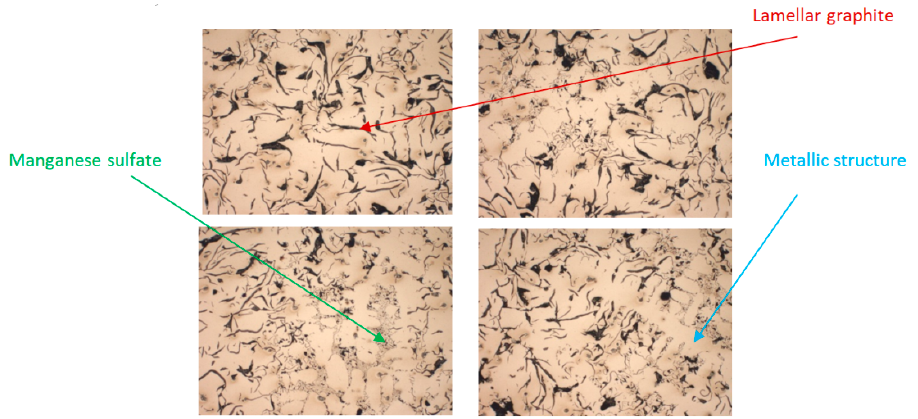
Figure 19. Microstructures of cast iron samples with lamellar graphite type EN-GJL-250, without metallographic attack at 100× magnification.